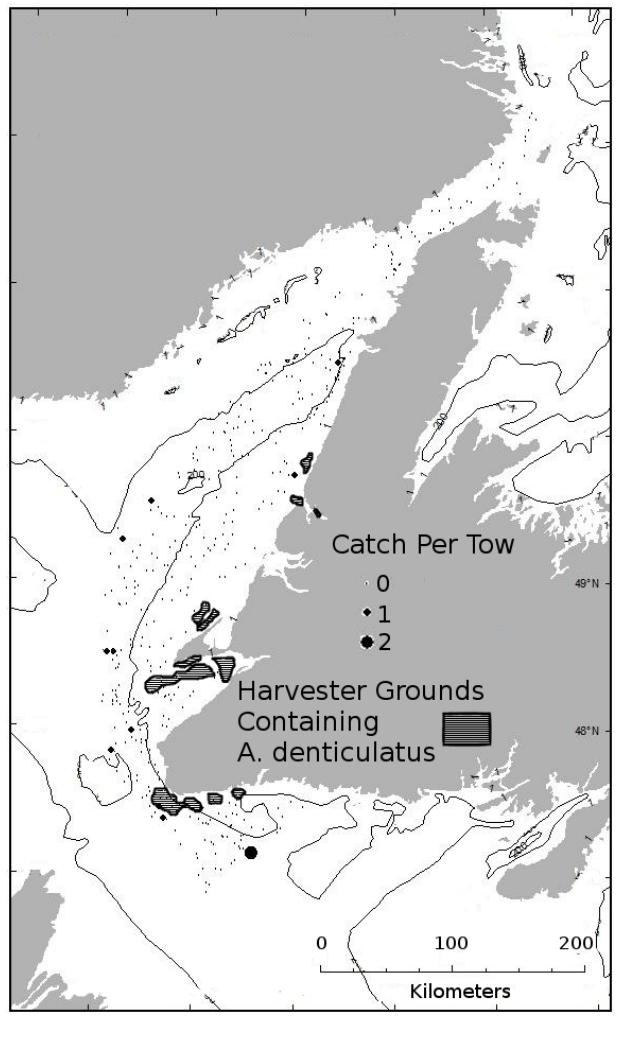
Fig. 4 . A comparison of fishery-independent data (bubble plot) and local ecological knowledge interview data (polygons) for Anarhichas denticulatus.